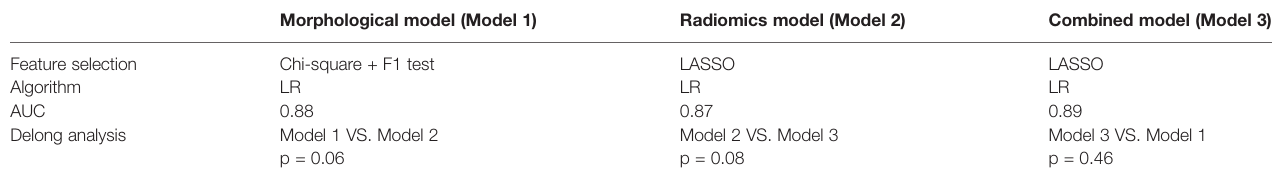
TABLE 4 | Comparison of morphological model, radiomics model, and combined